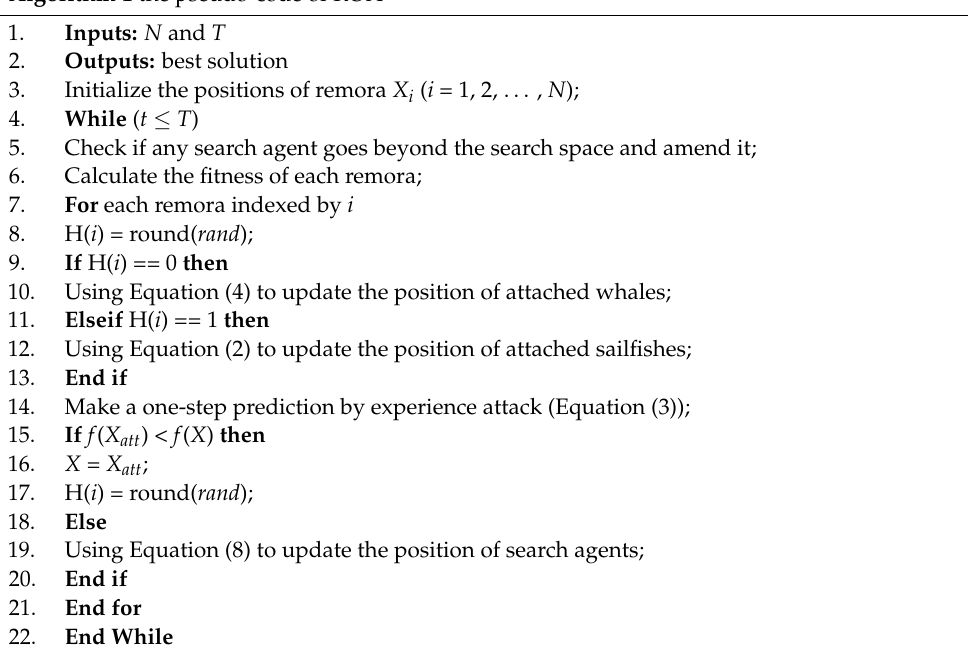
Algorithm 1 the pseudo-code of